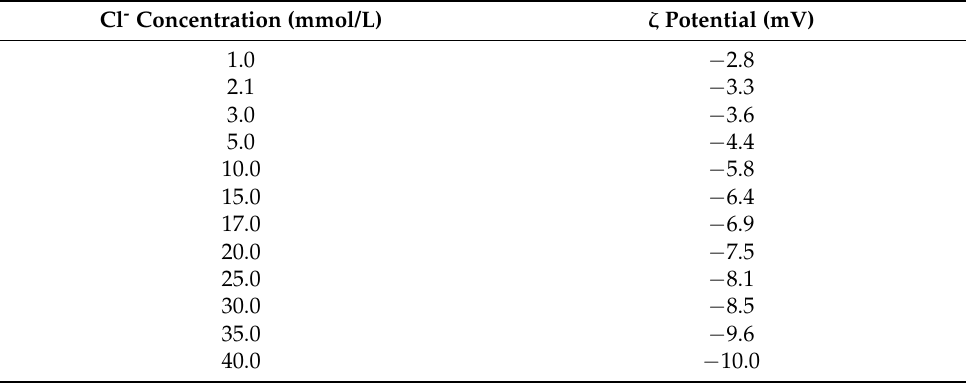
Table 10. Measured zeta potential C-S-H in CH with varying NaCl concentration [186].